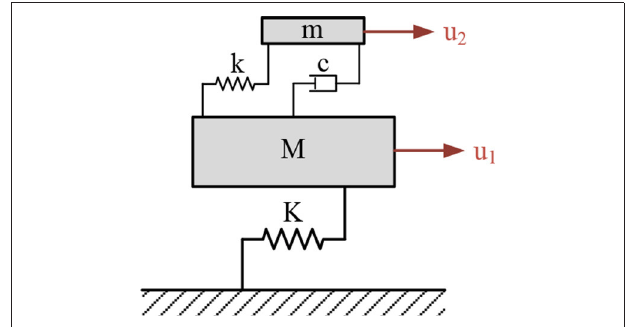
FIGURE 1 | Schematic representation of a dynamic vibration absorber for an undamped SDoF system as suggested by Hartog